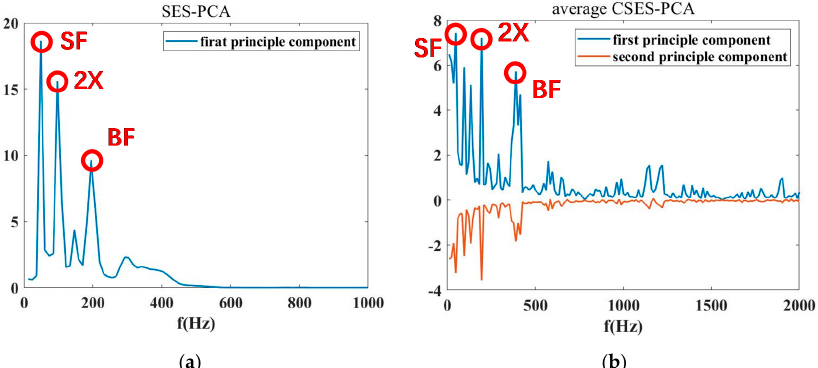
Figure 14. PCA selection of cyclic frequency components from SES and CSES spectra for CNRs and CNRc calculations. ( a ) The first principal component of SES-PCA. ( b ) The first and second principal components of CSES-PCA.